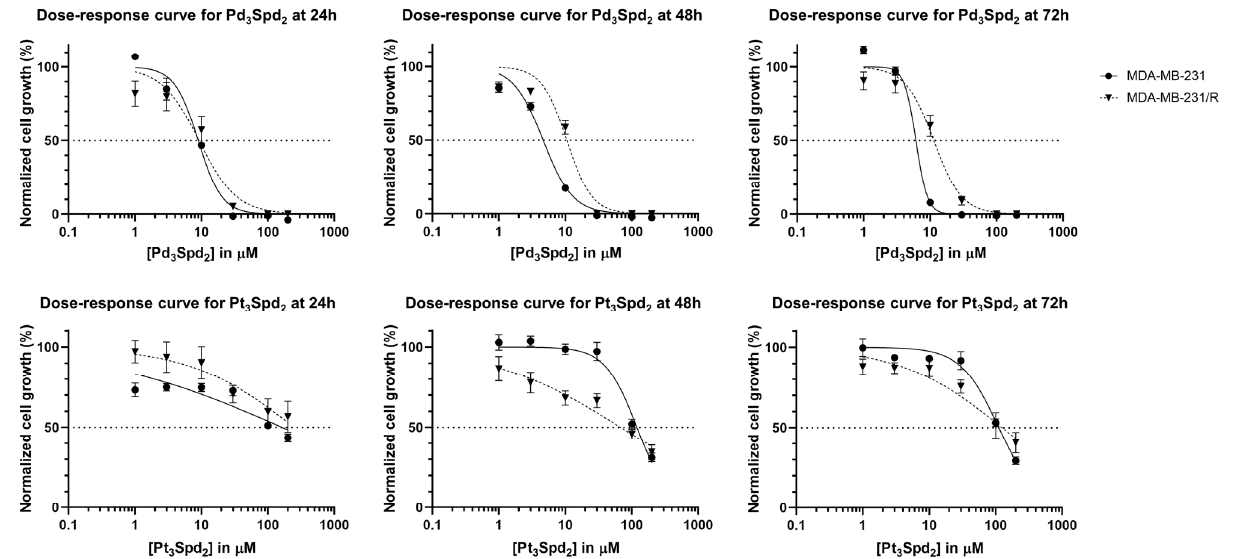
Figure 4. Impact of increasing concentrations of Pd 3 Spd 2 or Pt 3 Spd 2 on TNBC. Dose–response curves of Pd 3 Spd 2 ( upper panel ) and Pt 3 Spd 2 ( lower panel ) in breast cancer MDA-MB-231 and MDA-MB-231/R cells at 24, 48 and 72 h of incubation obtained through the MTT assay. Values are expressed as the mean ± SEM from 4 independent experiments (in triplicate) analyzed with nonlinear regression. Data points with no visible error bars have errors smaller than the size of the symbol. Table 2. Half-maximal inhibitory concentration (IC 50 ) of Pd 3 Spd 2 or Pt 3 Spd 2 against MDA-MB-231